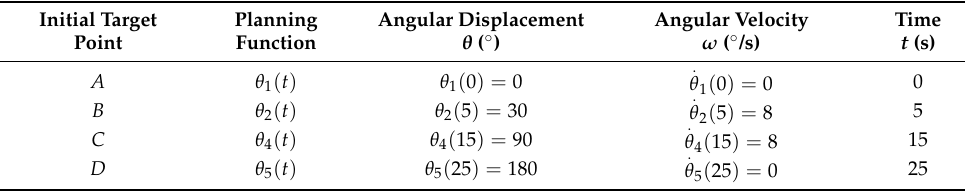
Table 3. Rotational requirement validation at the initial target